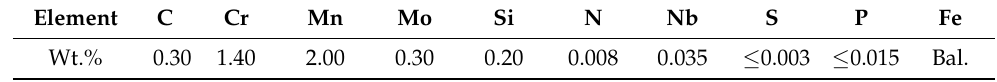
Table 1. Normal chemical composition of SDP1 plastic mould steel (wt.%).